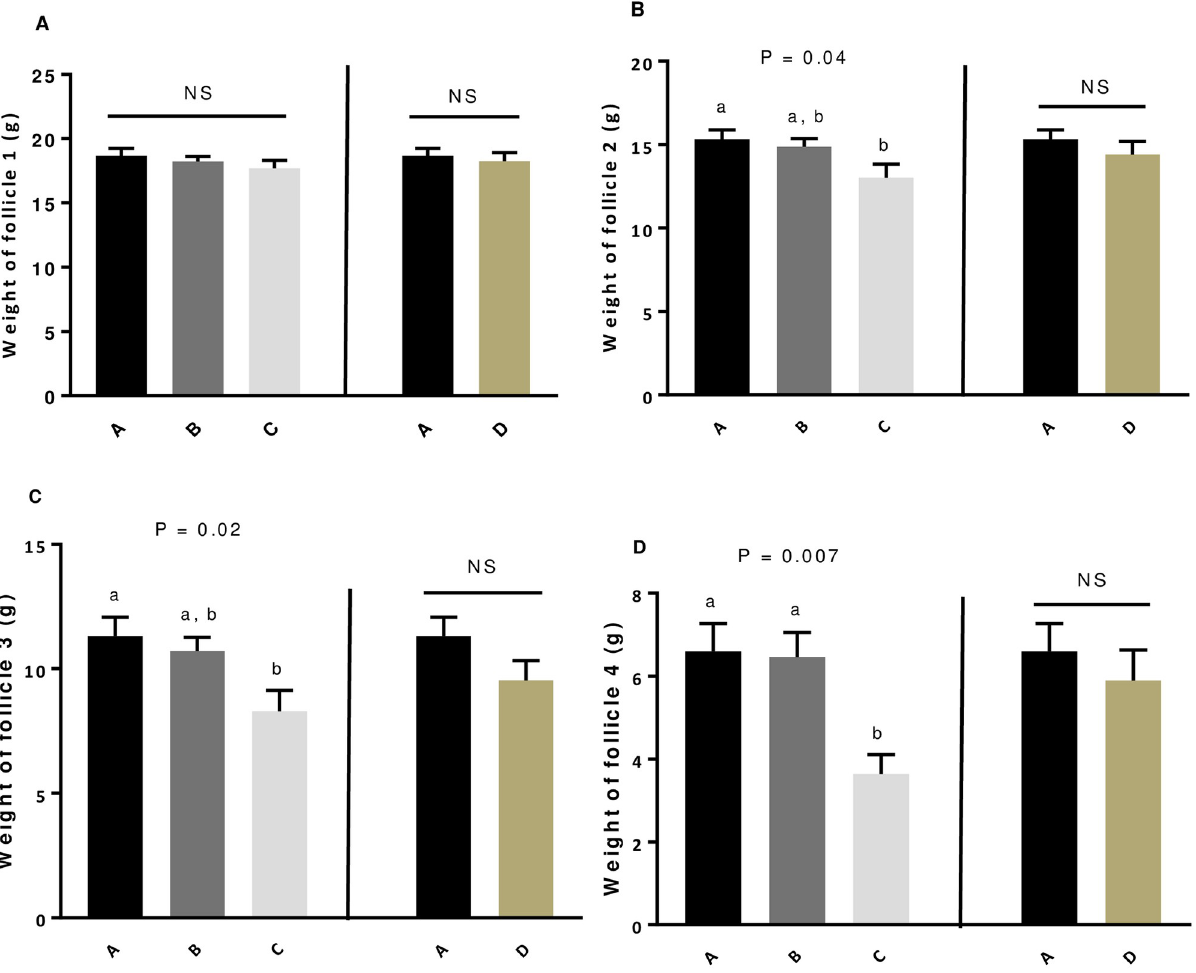
Fig 2. Weight of preovulatory follicles F1 (A), F2 (B), F3 (C) and F4 (D) of broiler hens fed with different concentrations of GSE supplementation. Follicular hierarchy of 10 animals selected randomly from each group (A to D) was analysed at the 40th week. Each preovulatory follicle from each animal was weighed. A: animals fed with control diet without GSE supplementation, B and C: animals supplemented with GSE at 0.5% and 1% of the total diet composition, respectively, starting at 4 week-old until 40 week-old, and D: supplementation with GSE at 1% of the total diet composition starting at hatch until 40 week-old. Results are presented as lsmeans ± S.E.M. P values and different individual letters indicate a significant effect of the diet between A, B and C groups (experiment 1) or between A and D (experiment 2) groups. P value was considered as significant if P <